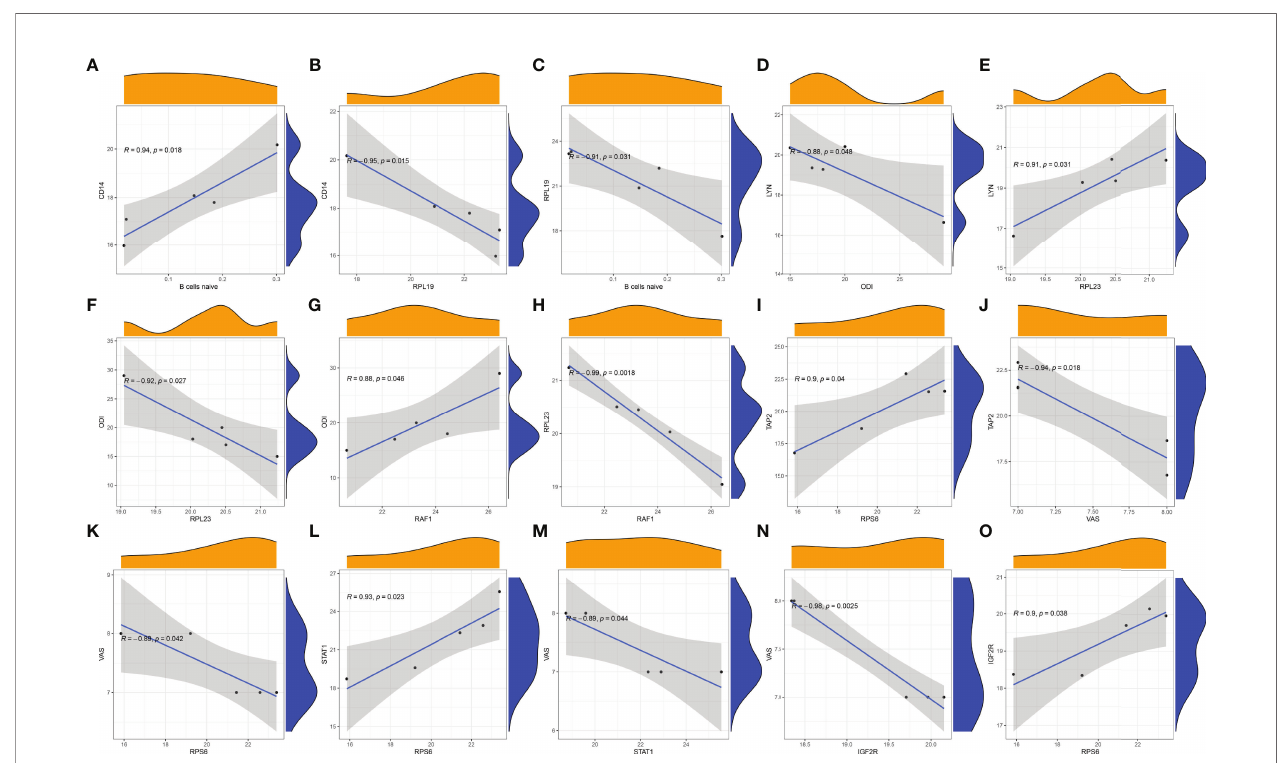
FIGURE 10 | Correlation analysis was plotted. (A) Correlation analysis of B cells naive and CD14. (B) Correlation analysis of RPL19 and CD14. (C) Correlation analysis of B cells naive and RPL19. (D) Correlation analysis of LYN and ODI. (E) Correlation analysis of RPL23 and LYN. (F) Correlation analysis of RPL23 and ODI. (G) Correlation analysis of RAF1 and ODI. (H) Correlation analysis of RPL23 and RAF1. (I) Correlation analysis of TAP2 and RPS6. (J) Correlation analysis of TAP2 and VAS. (K) Correlation analysis of RPS6 and VAS. (L) Correlation analysis of RPS6 and STAT1. (M) Correlation analysis of STAT1and VAS. (N) Correlation analysis of IGF2R and VAS. (O) Correlation analysis of RPS6 and